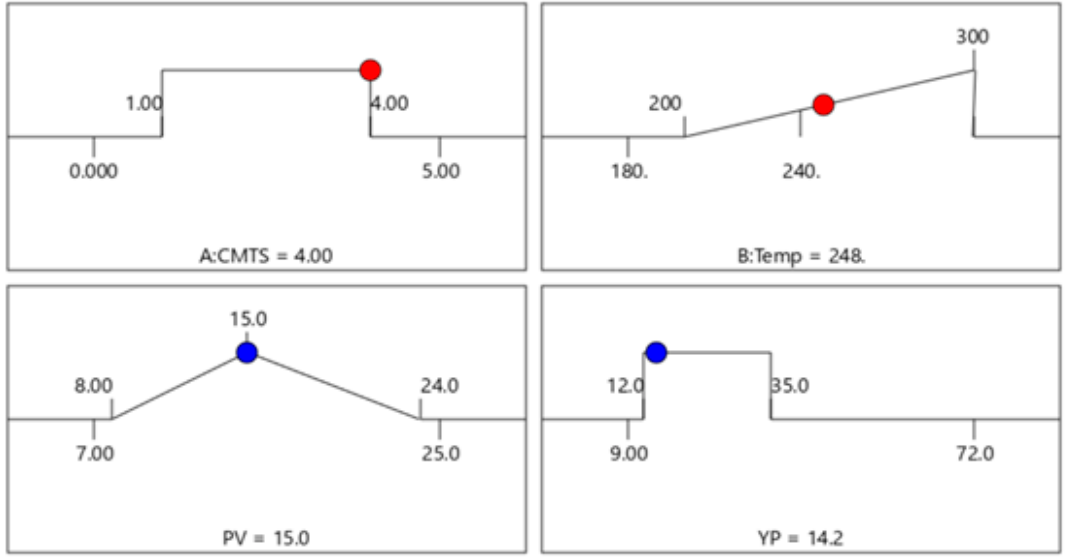
Figure 10. DOE Optimization solutions. Table 8. Rheological parameters in optimal conditions. CMTS Conc.